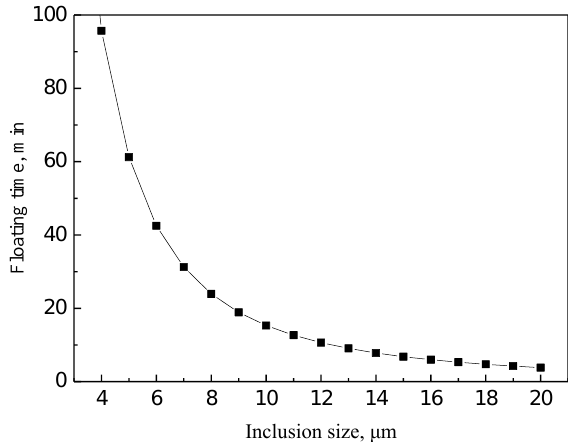
Figure 9. The relationship between the particle size and the time of inclusion floating up.